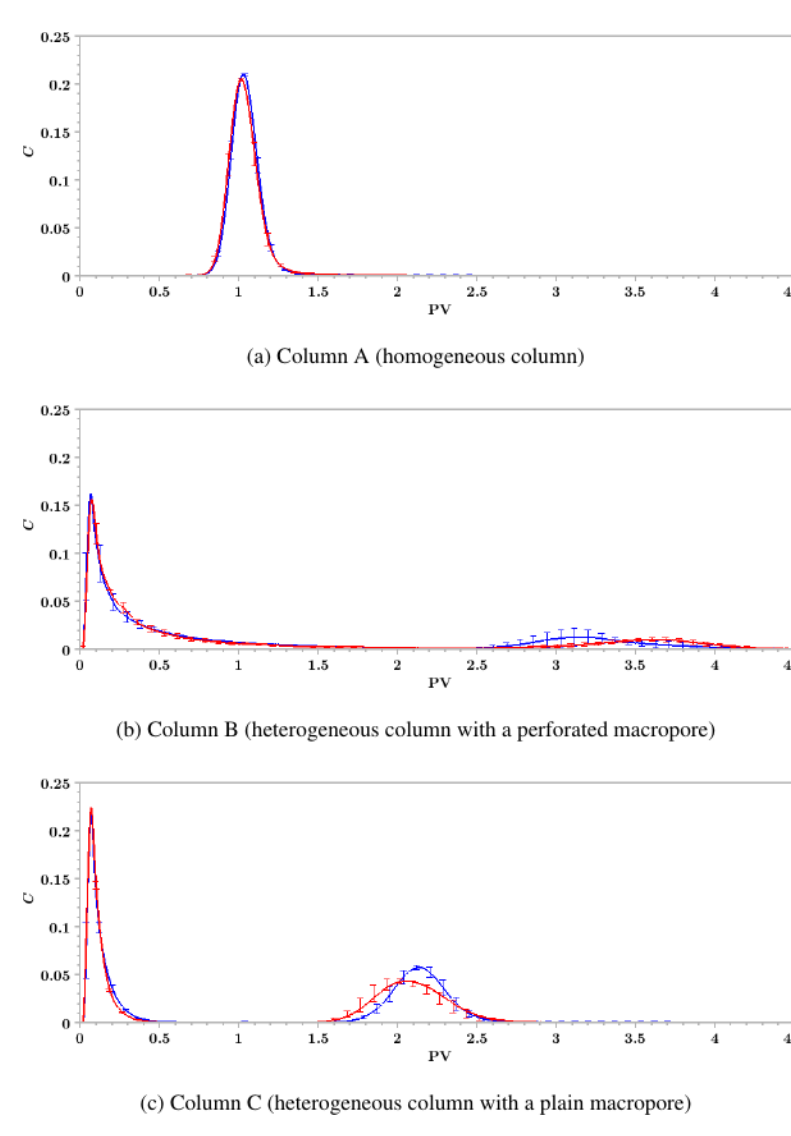
Figure 3. Breakthrough curves showing the normalized concentration, C , as a function of the number of pore volumes, PV, measured at the outlet of columns A, B and C in the presence (blue curve) and the absence (red curve) of an outlet filter. Each breakthrough experiment was conducted three